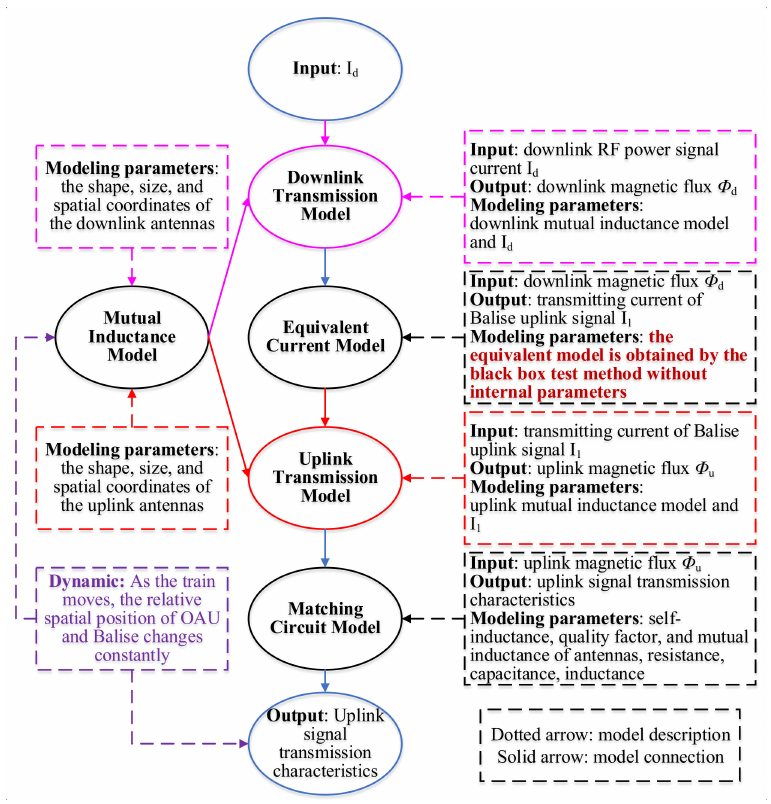
Figure 10. DT model of electromagnetic coupling process of